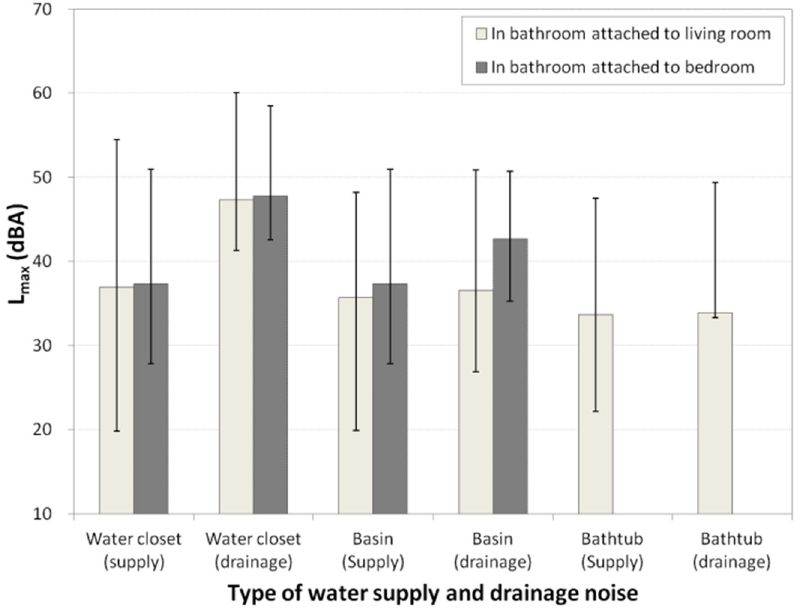
Figure 8. Average noise level for each sanitary ware measured in the bathrooms of the lower floor attached to the living room ( N = 64) and bedroom ( N = 49). The deviation bar indicates the range between the maximum and minimum noise levels measured in the different bathrooms.